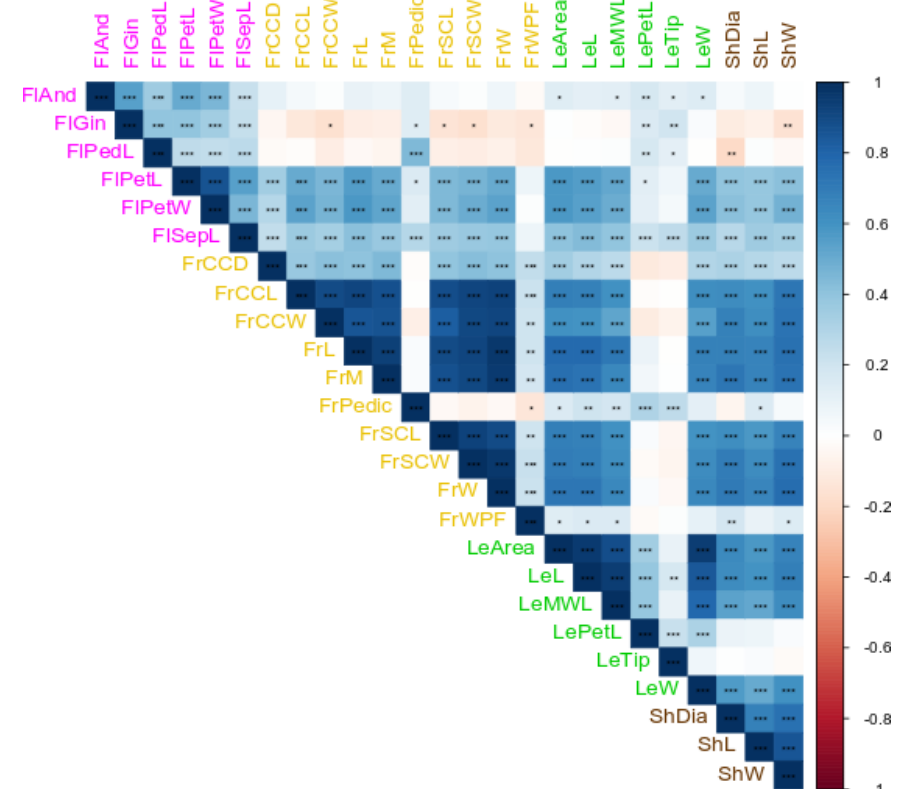
Figure 3. Correlation matrix plot for continuous and ordinal apple descriptors assessed on old traditional apple cultivars. Shoot colour (ShCol) could not be computed due to a lack of variation at a tree level. Descriptors are coded as in Table 3. ***, P ≤ 0.001; **, P ≤ 0.01; *, P ≤ 0.05; no asterisk, non-significant